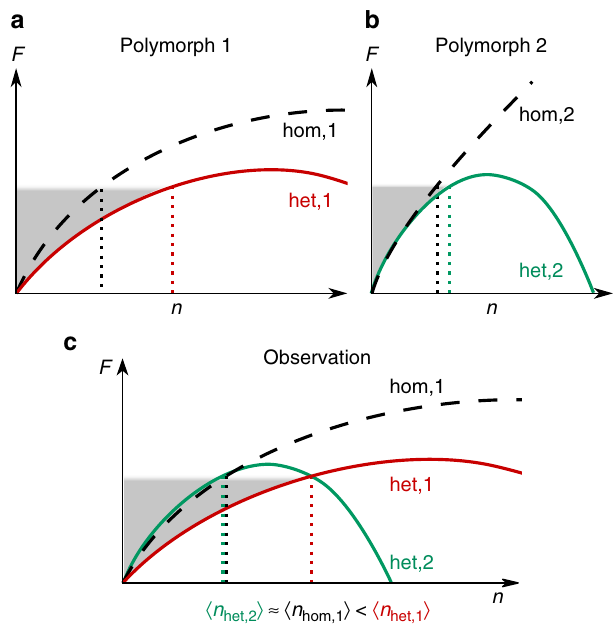
Fig. 4 Schematic illustration of the connection between free energy pro fi les, precritical fl uctuations, and polymorph. a , b Resulting het. free energy pro fi les for two different polymorphs, which belong to the same functional family as their hom. reference. The extent of thermal fl uctuations is indicated by the gray-shaded area. c Observation in a simulation or experiment where the hom. nucleation of the dominant polymorph 1 is compared to het. nucleation events that form the same (het,1) and a different (het,2) polymorph. While for the het,1 pro fi le the critical nucleus and the barrier are scaled by a same factor (as predicted by hetCNT), these are scaled differently for the het,2 pro fi le when compared to hom,1. Note that the graphs are qualitatively equivalent to our simulation results, but do not result from a fi t or parametrized